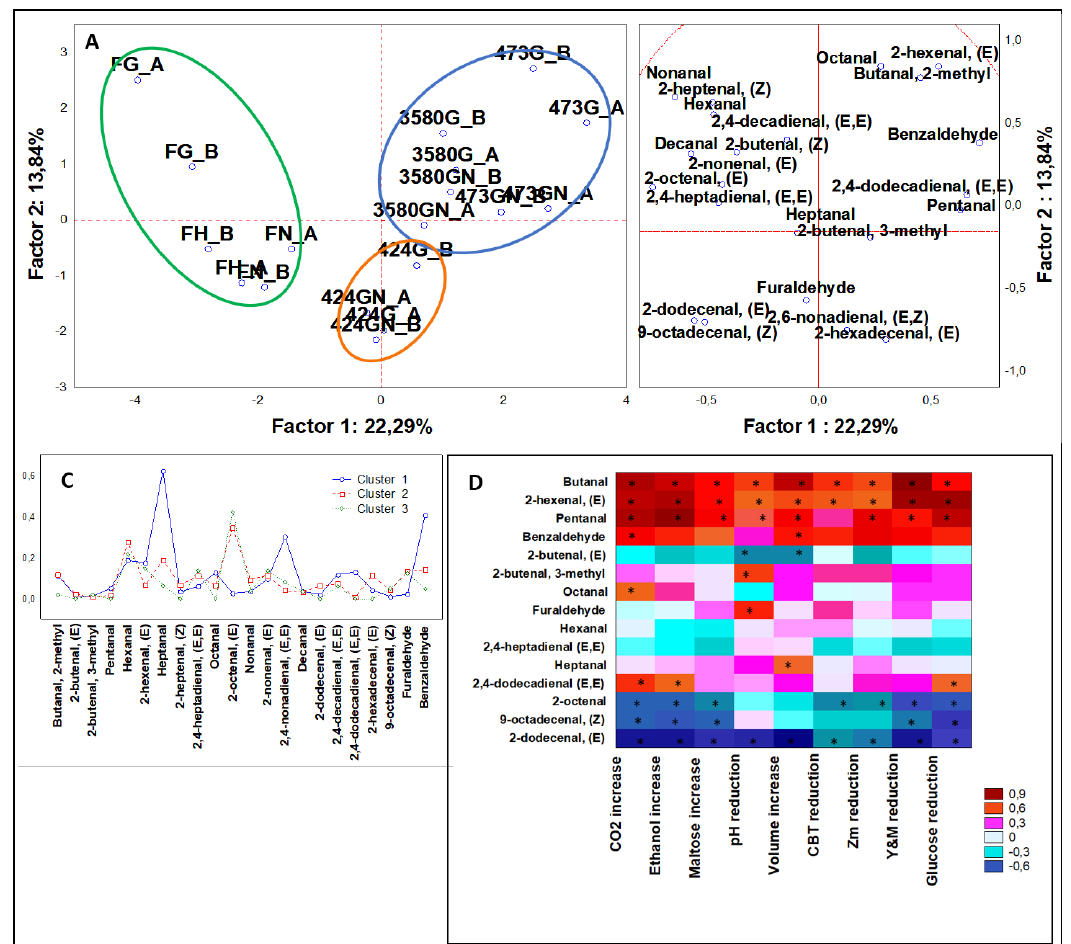
Figure 4. ( A ) PCA of cases and ( B ) variables on aldehydes; ( C ) K-means clustering; ( D ) Spearman